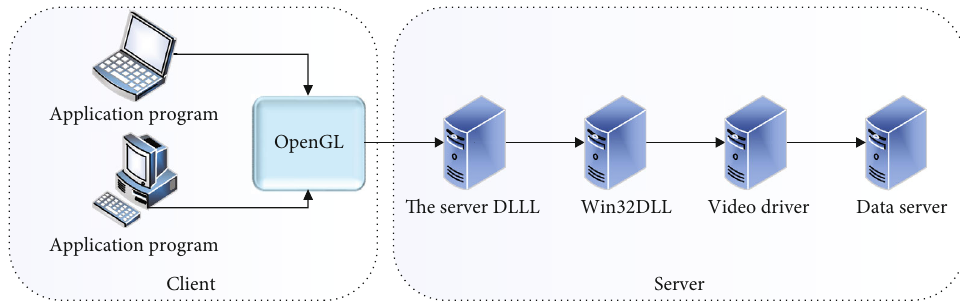
Figure 1: System process mechanism process diagram.